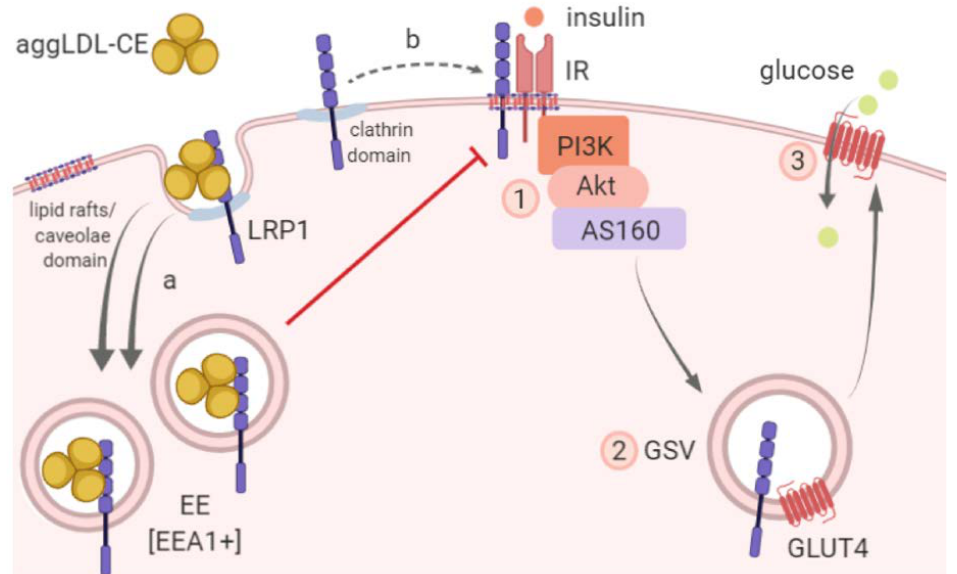
Figure 6. LRP1-mediated aggregated LDL uptake and impaired insulin response in HL-1 cells. LRP1